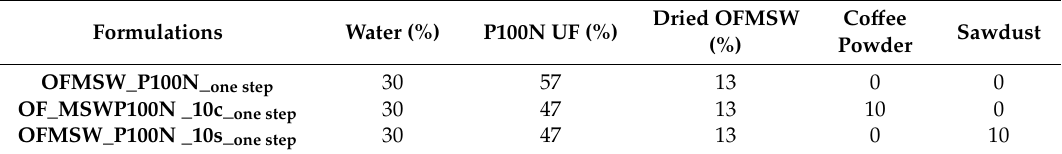
Table 2. Blends composition (one step